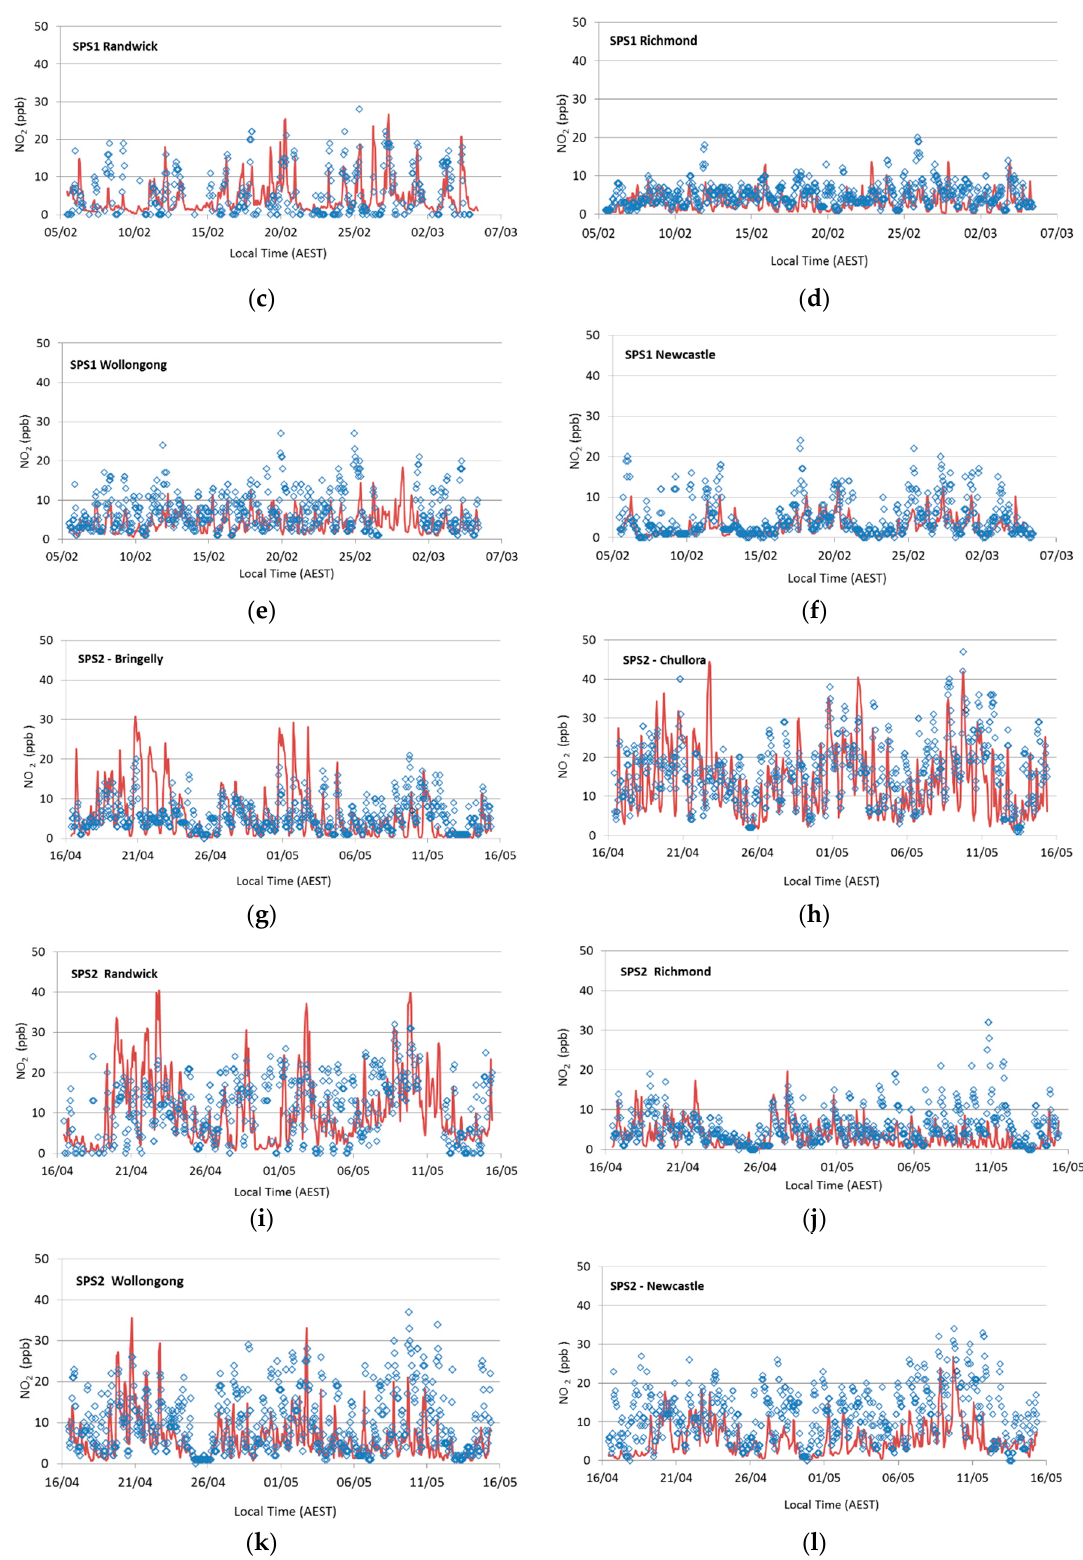
Figure 13. The time series of predicted (red line) and observed (blue hollow dot) hourly NO 2 (ppb) at selected 6 OEH stations during: SPS1 ( a – f ); and SPS2 ( g – l ).